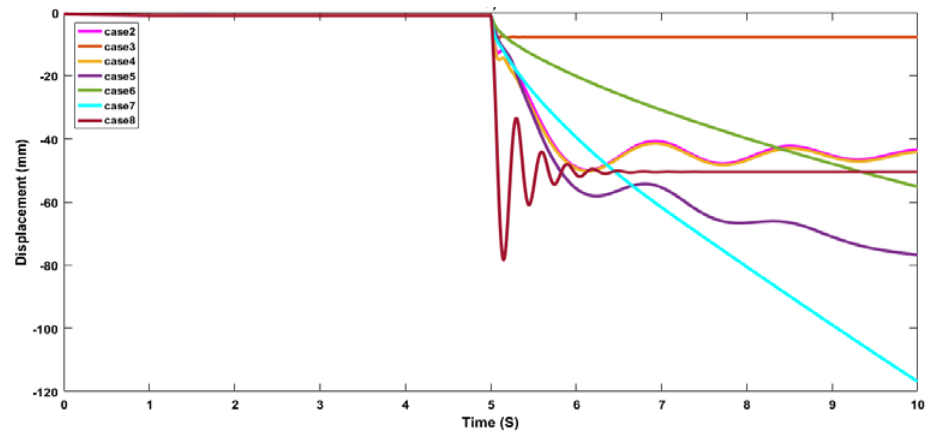
Figure 15. Vertical displacement at column removed position due to column loss in story one.